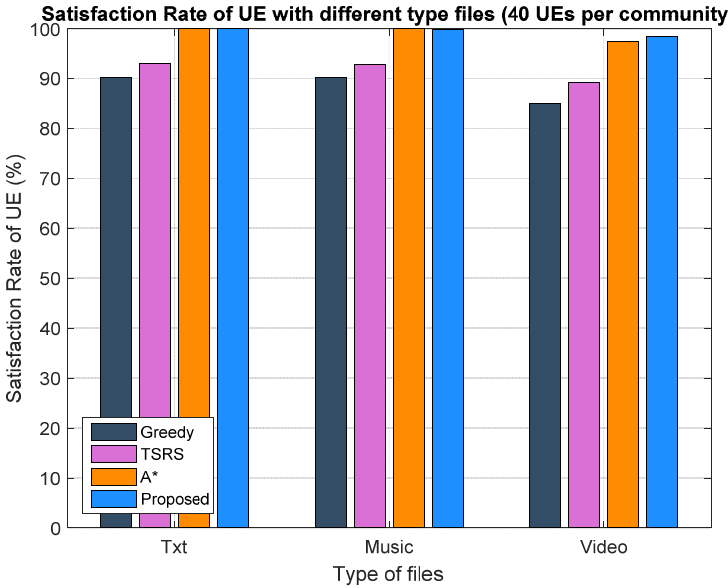
Figure 19. Satisfaction rates of different content types.